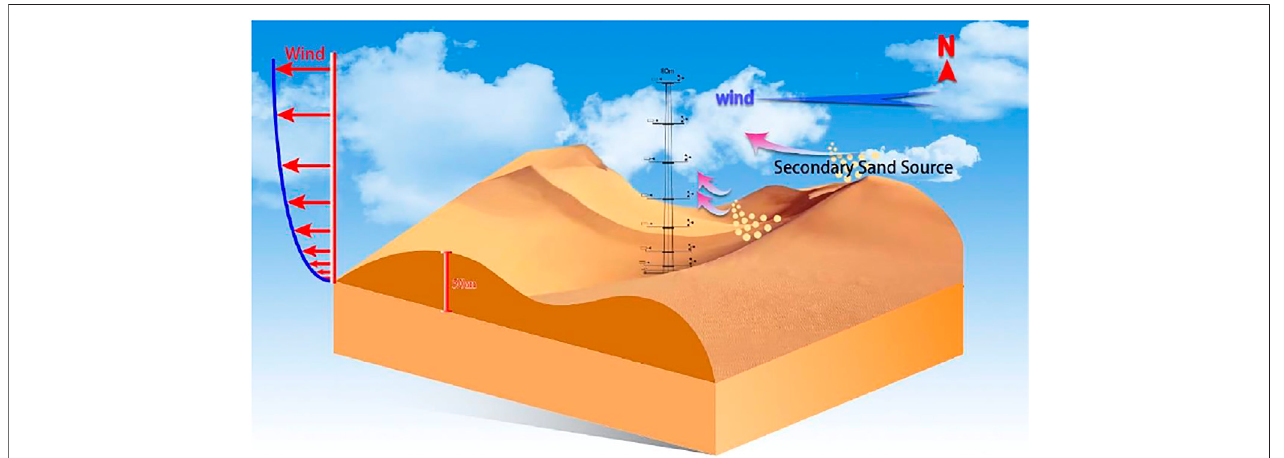
FIGURE 10 | Conceptual diagram of dust transport from multiple sand sources during a dust storm in TZ.